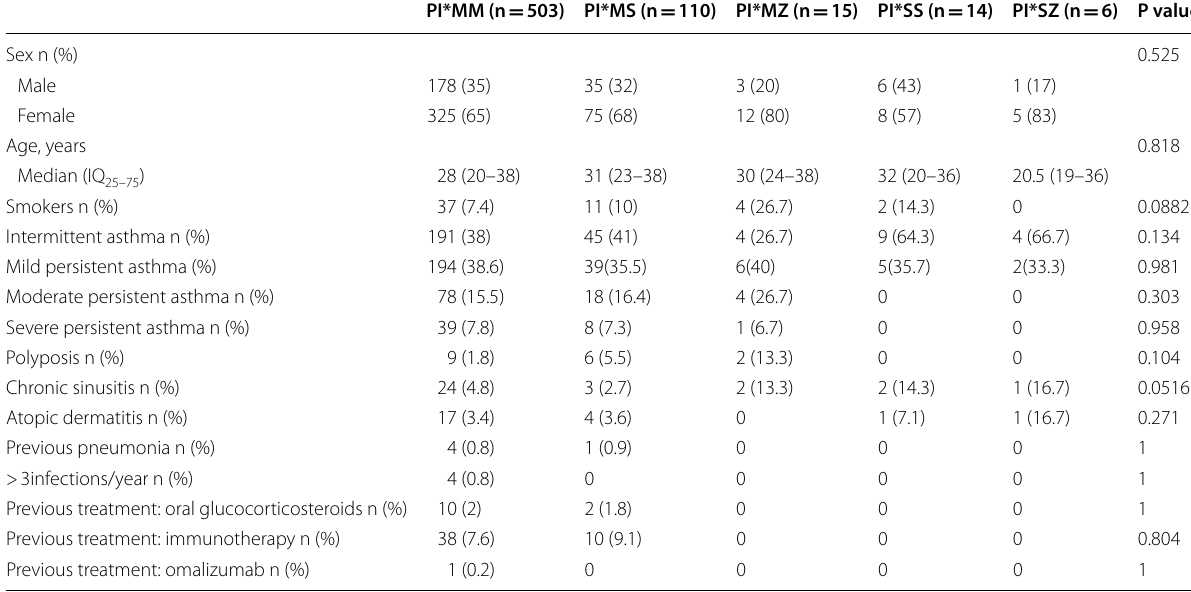
* Kruskal–Wallis statistic analysis for continuous non normal variables and Chi square or F‑test for nominal